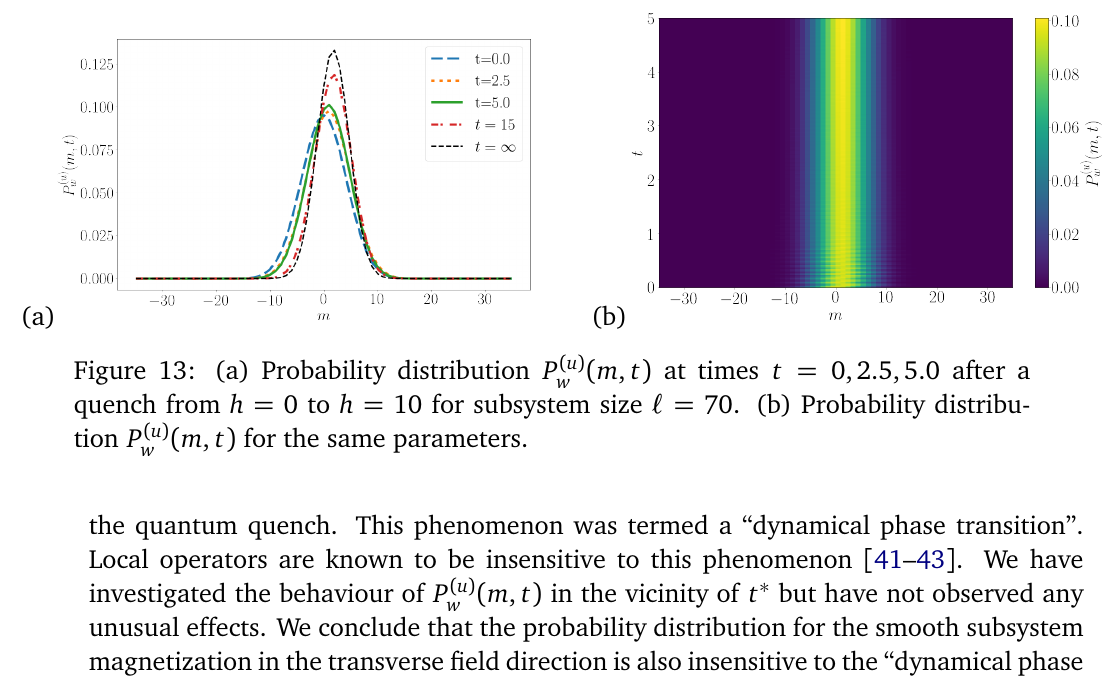
Figure 13: (a) Probability distribution P ( u ) quench from h = 0 to h = 10 for subsystem size (cid:96) = 70. (b) Probability distribu- ( m , t ) for the same tion P ( u ) w